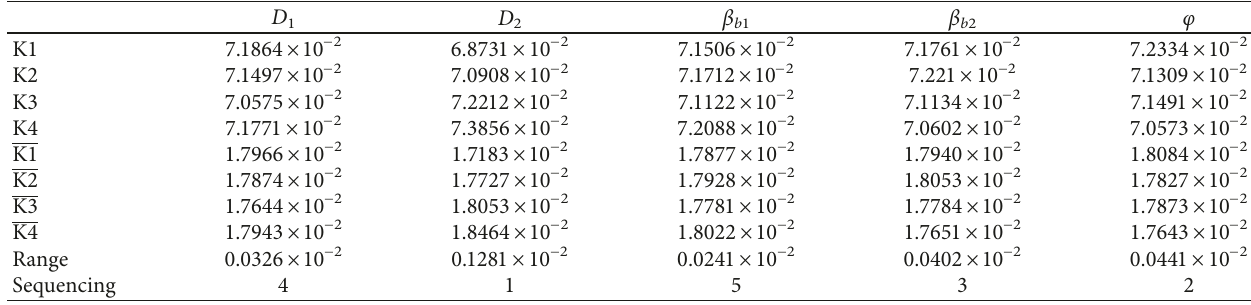
Table 8: Influence data of various factors on total displacement.